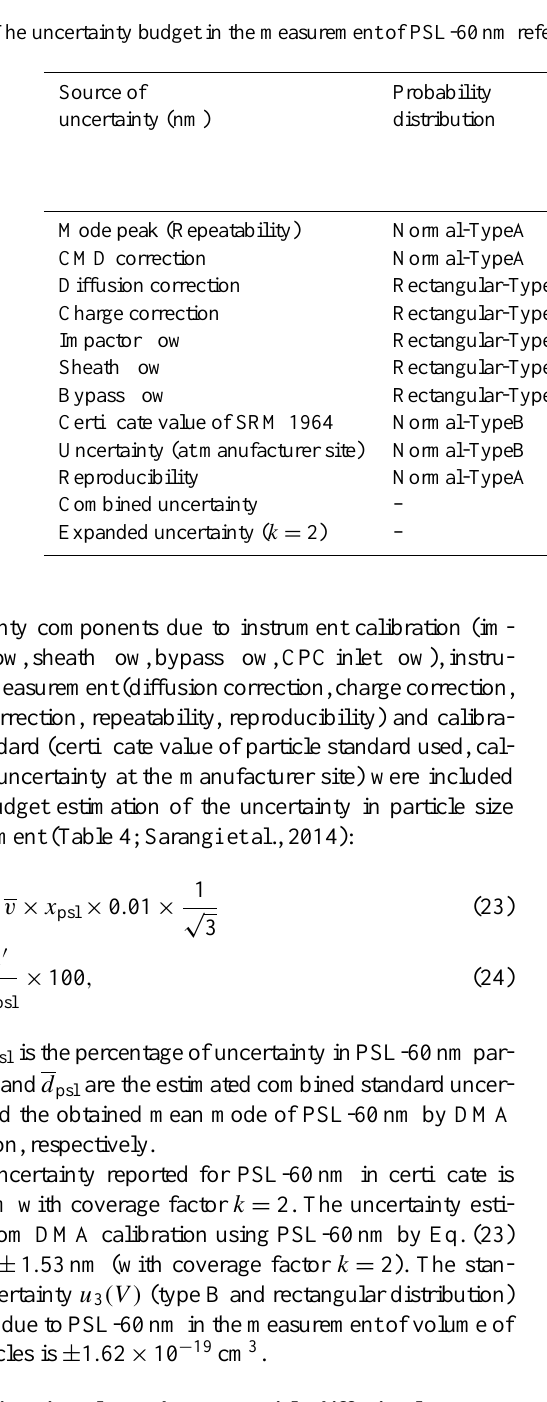
Sample Sample SET-1 SET-2